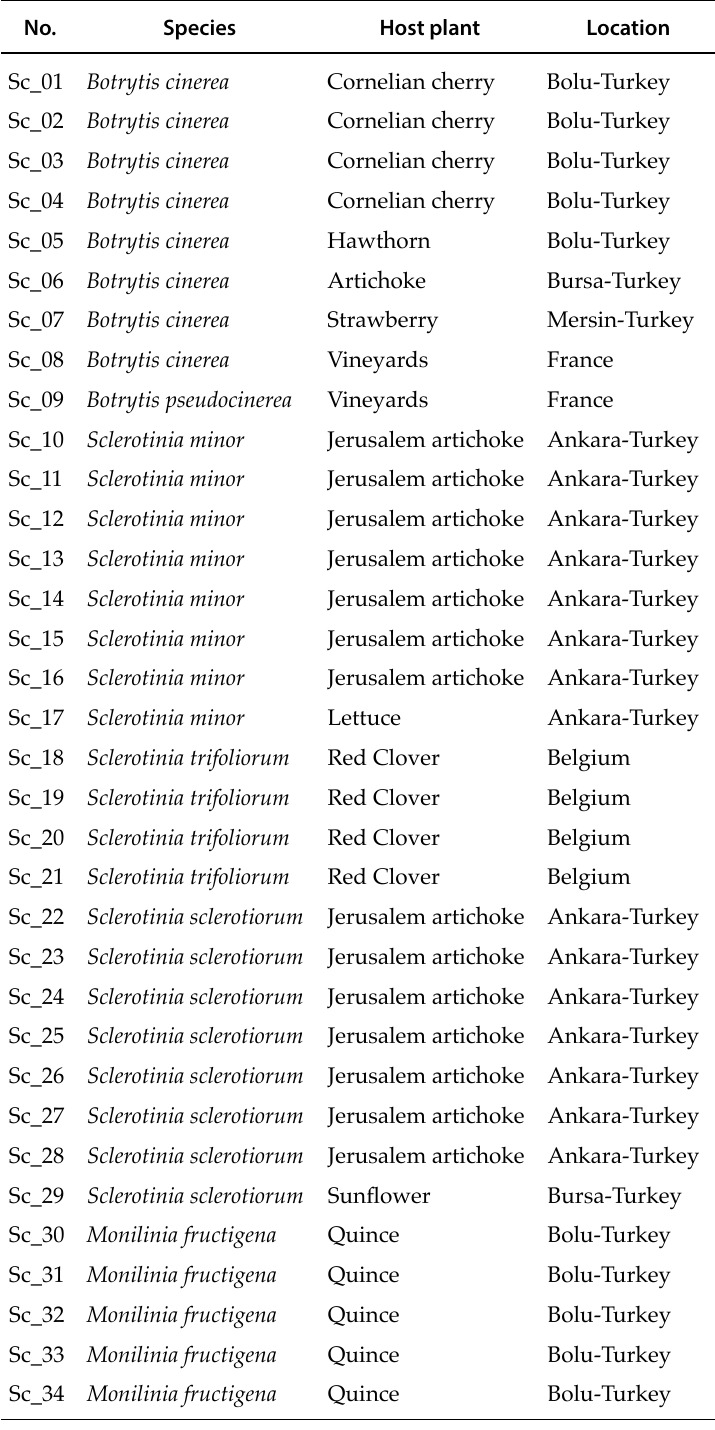
Table 1. Thirty-four fungal isolates, representing six species in